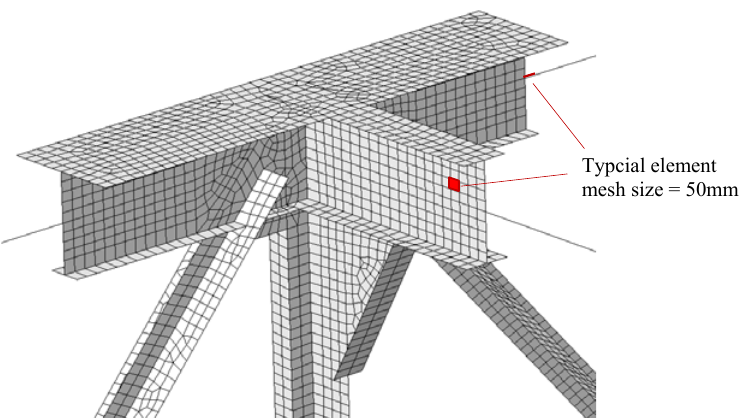
Figure 3. General finite element mesh within connection